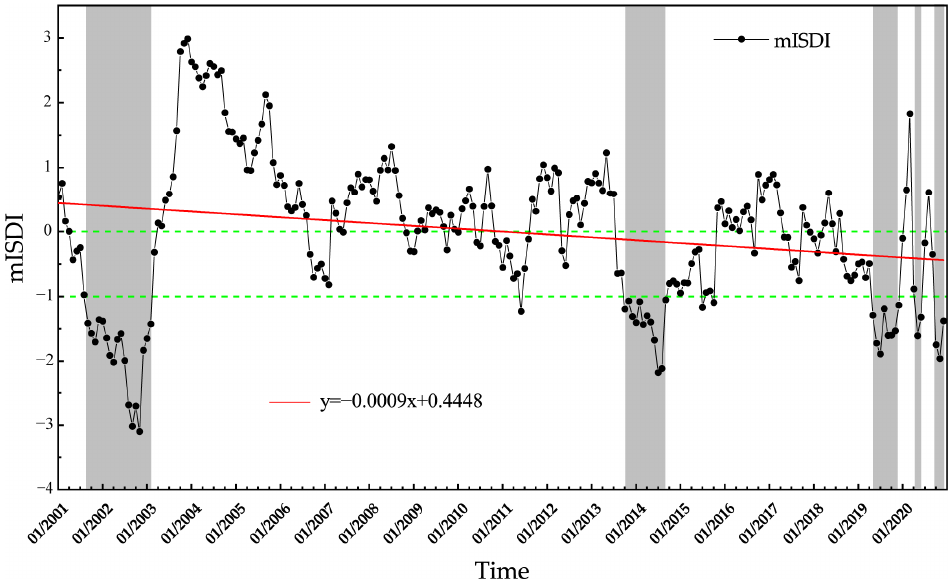
Figure 5. Variations of the average mISDI of the HHHP. A bar shade represents a drought